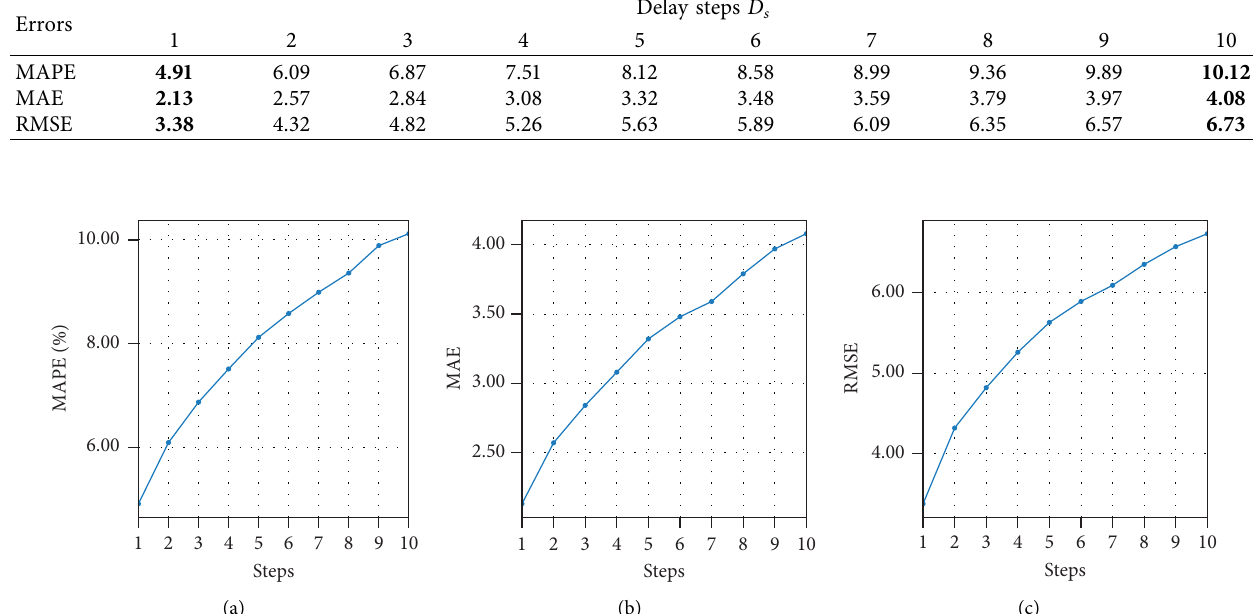
Table 2: Multistep delay prediction errors of the LSTM model on detector 16,885.